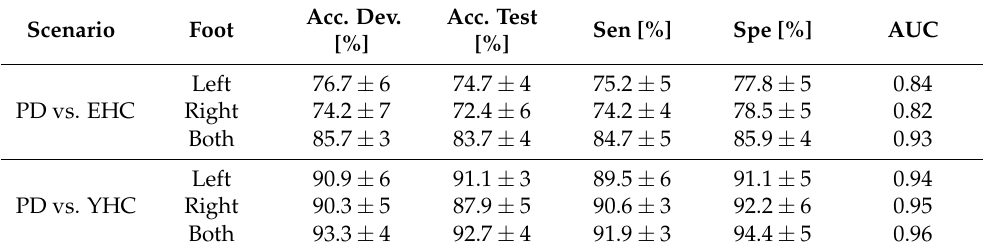
Table 7. Results using CNN + GRU and 4 × 10 m task.